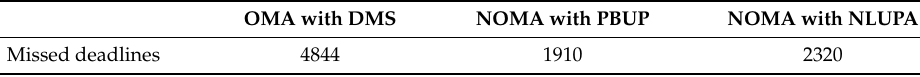
Table 6. Missed deadline comparisons.